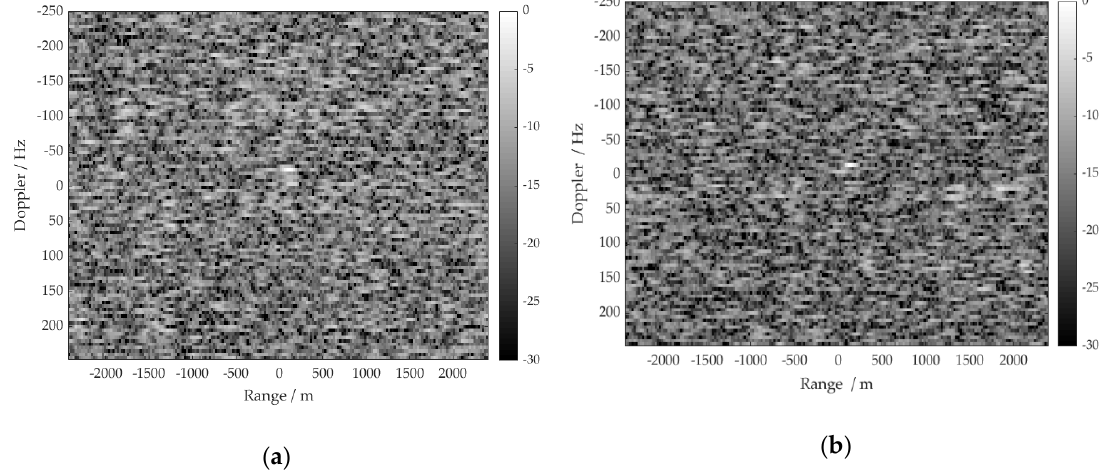
Figure 16. Experimental range-Doppler maps at frame-3: ( a ) SVN #12 is used as transmitter ( b ) SVN #25 is used as transmitter.